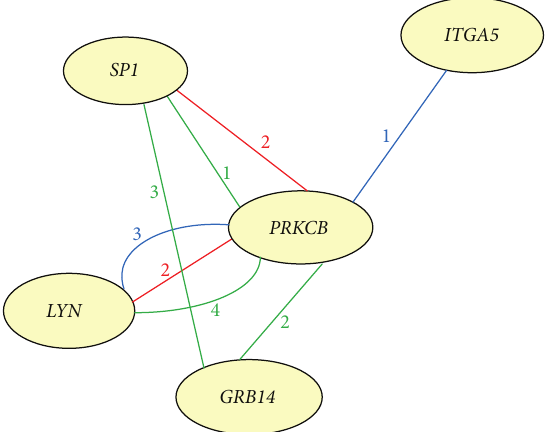
Figure 3: Correlation pathways of candidate genes. Red line, BioCarta; green line, GenMAPP; blue line, KEGG; number: counts of correlation pathways of two